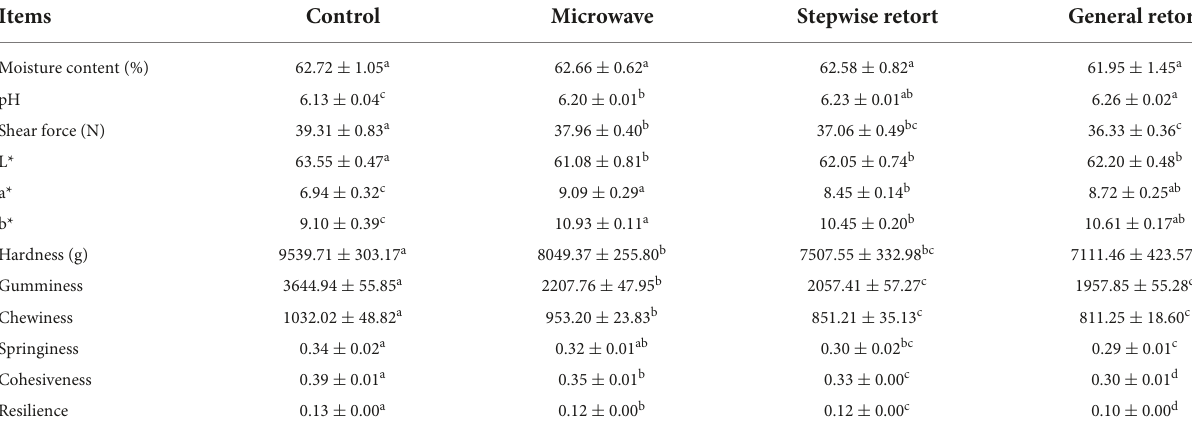
TABLE 1 Basic physiochemical properties of duck meat treated with no thermal sterilization and three sterilization strategies. Items Control Microwave Stepwise retort General